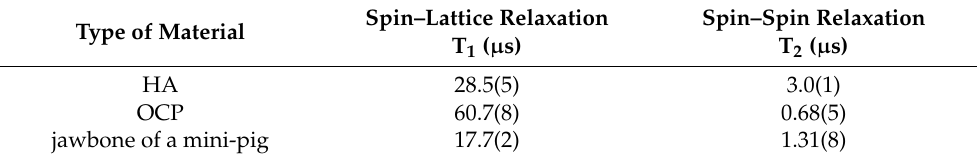
Table 2. Relaxation characteristics of radiation-induced paramagnetic centers in different matrices at room temperature T = 297 K, in the X-band frequency range ν MW = 9.6 GHz. Values for CP materials were measured at B 0 (see Figure